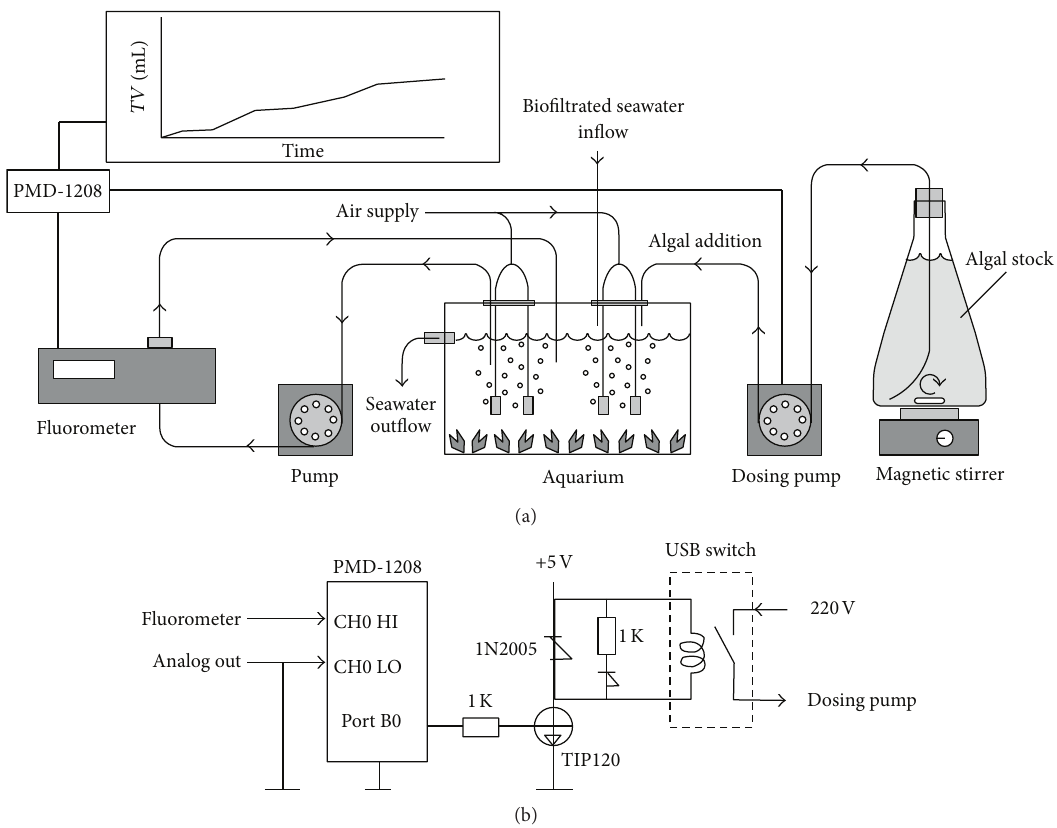
Figure 1: Fluorometer controlled apparatus (FCA). (a) Schematic drawing of automatic recording apparatus for continuous measurement of filtration rate of mussels at constant algal concentration. Biofiltrated seawater is flowing through a well-mixed aquarium with blue mussels, Mytilus edulis , at a constant rate. Water from the aquarium is continuously pumped through a cuvette in the fluorometer monitoring the algal concentration and back again into the aquarium. When the algal concentration decreases below a fixed trigger level, the dosing pump is activated to add algal suspension from a stock. The total volume ( 𝑇𝑉 ) of an algal suspension added over time is stored automatically. (b) Circuit scheme of apparatus. Analog output of fluorometer is connected via an A/D converter (12bit A/D input of the PMD-1208LS USB- based personal measurement device from measurement computing) to a computer. The measured fluorescence of suspended algal cells in the aquarium correlates with a known cell concentration. When the fluorescence comes below a defined lower trigger value Port B0 sends a pulse to the dosing pump and a defined volume of an algal suspension is added into the